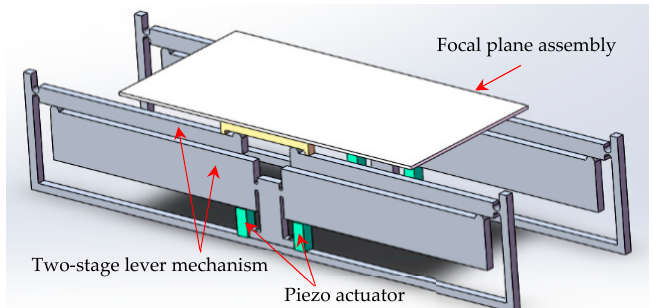
Figure 2. Simplified theoretically structural schematic of the focusing mechanism based on a two-stage flexural hinge lever-type mechanism. The focusing mechanism is composed of the same two sets of structural configurations.